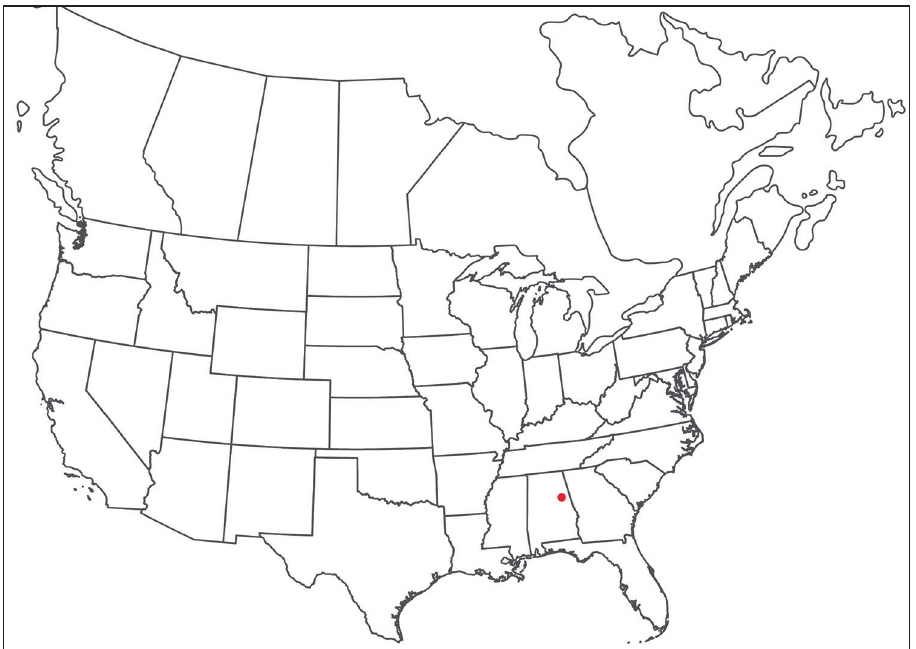
Figure 44. Torrenticola daemon sp. n.